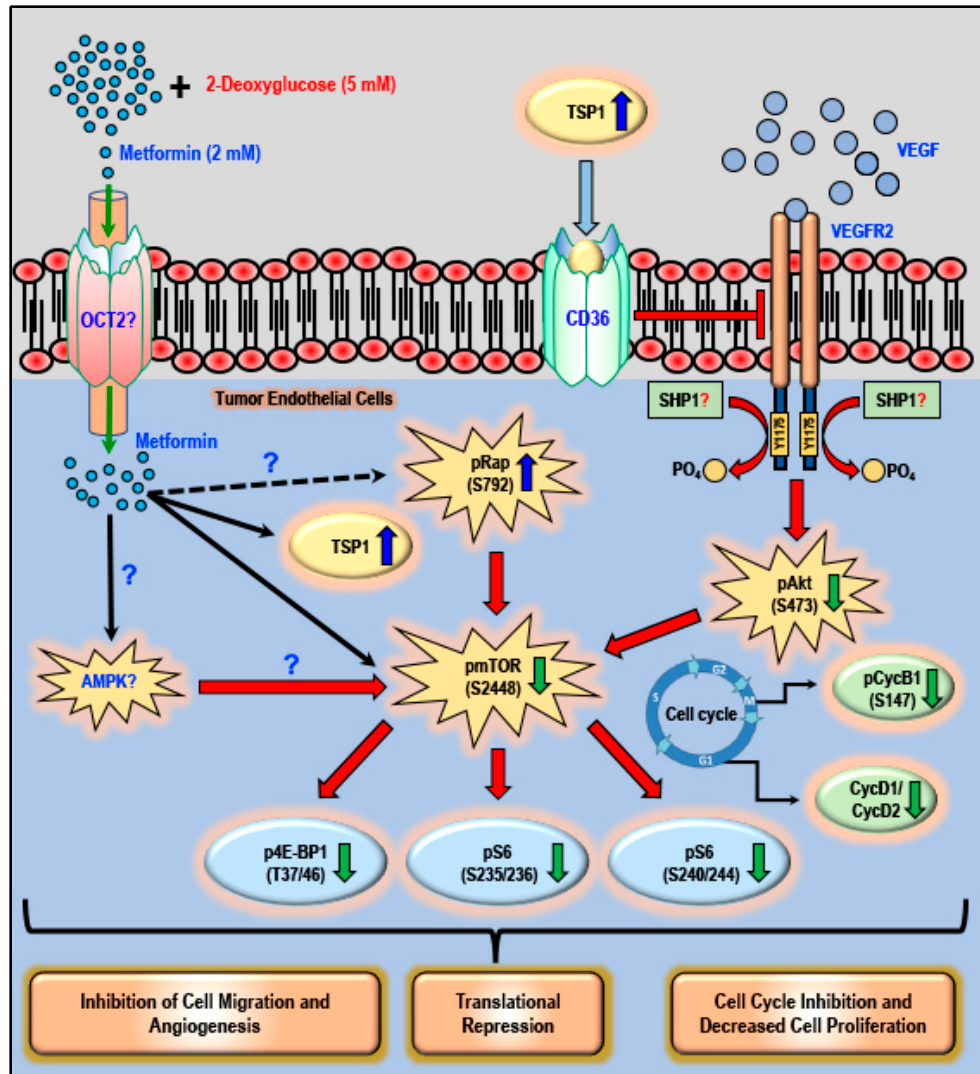
Figure 11. Targeting angiogenesis in tumor endothelial cells with a combination of metformin and 2DG: The schematic illustrates the possible cellular sites of action when using a combination of metformin and 2DG in tumor endothelial cells. It is possible that metformin accumulates in the tumor endothelial cells via OCT2 and requires futher thorough investigation. A combination of 2DG (5 mM) and metformin (2 mM) causes a robust increase in the levels of anti-angiogenic TSP1, which then binds to its receptor CD36 and negatively regulates the phosphorylation of VEGFR2 at Y1175. A decrease in the levels of pVEGFR2 (Y1175), in turn, reduces the levels of phospho-Akt (S473). The combination treatment (DG and metformin) also increases the levels of phospho-Rap (S792). The increase in the levels of inhibitory pRap (S792) and decrease in pAkt (S473) subsequently decreases the levels of phospho-mTOR (S2448), resulting in the decrease in the levels of downstream phospho-4E-BP1 (T37 / 46) and phospho-S6 ribosomal protein (S235 / 236 and S240 / 244). The combination treatment also reduces the levels of cell-cycle-associated phospho-CycB1 (S147), CycD1 and CycD2. These molecular events associated with the combination therapy (2DG + metformin) result in translational repression, inhibition of cell migration and angiogenesis and the inhibition of cell cycle and proliferation. Further investigations are warranted to ascertain or rule out the possible role of AMPK in the effect that we have seen on the levels of phospho-Rap and inhibition of the mTOR pathway when using a combination of 2DG and metformin.